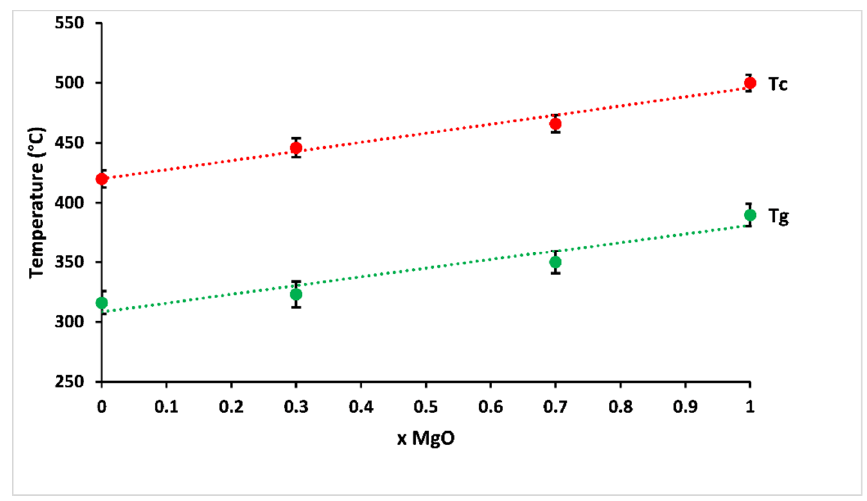
Figure 4. Glass transition (Tg) and crystallisation (Tc) temperatures of prepared glasses according to MgO contents.